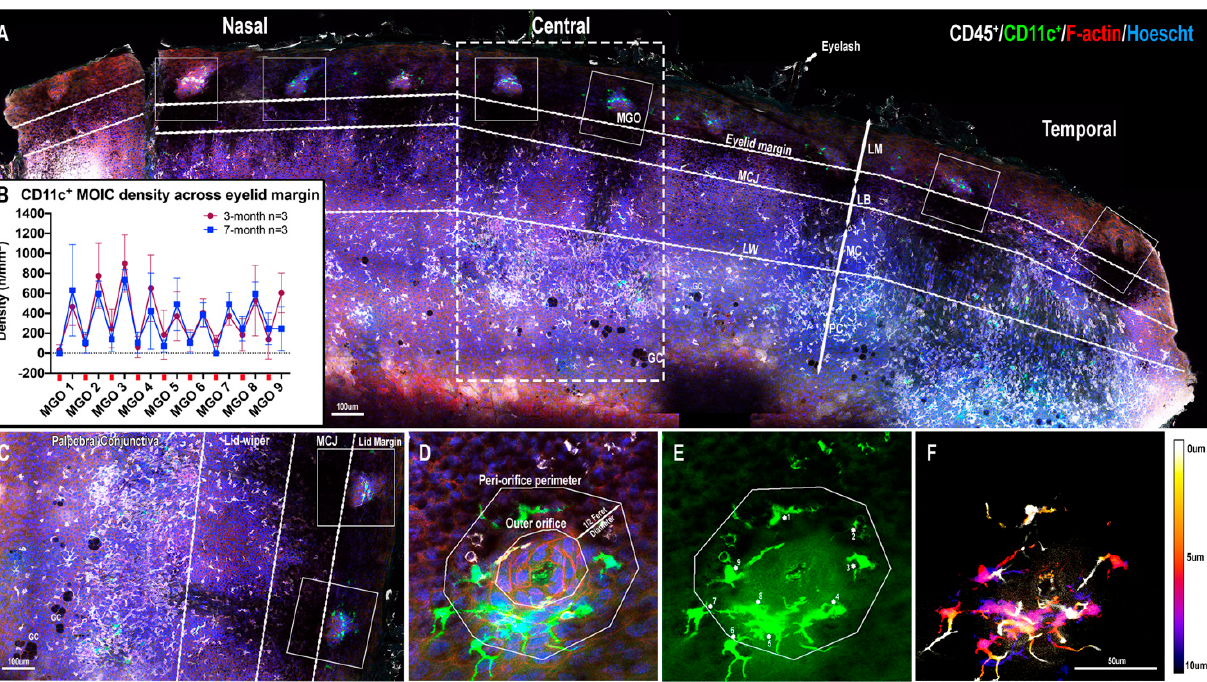
Figure 1. Low-power view of eyelid flatmount showing imaging approach. ( A ) Two adjacent MGOs in each eyelid region (nasal, central, and temporal) were imaged using confocal microscopy. ( B ) Graphical depiction of CD11c + MOIC density across a typical eyelid margin including MGO and inter-MGO spaces (red dashes on X-axis). ( C ) An enlarged image of the central eyelid (dotted box in A). ( D ) MOICs surrounding an MGO highlighted by F-actin (red). Peri-orifice area is calculated by adding half the Feret diameter of the outer orifice. ( E ) CD11c + MOICs within the peri-orifice area were manually counted. ( F ) Depth-colour projection of CD11c + MOICs around an MGO of ( E ) where cooler colours represent MOICs located deeper in the duct and warmer colours indicate cells closer to the epithelial surface. Dendrites can extend towards the epithelium and deeper to 10 μ m. The same scale bar in ( F ) applies to ( D , E ). Lid margin, LM, lid margin border, LB, marginal conjunctiva, MC, palpebral conjunctiva, PC, mucocutaneous junction, MCJ, lid-wiper area, LW, goblet cells, GC, meibomian gland orifice,